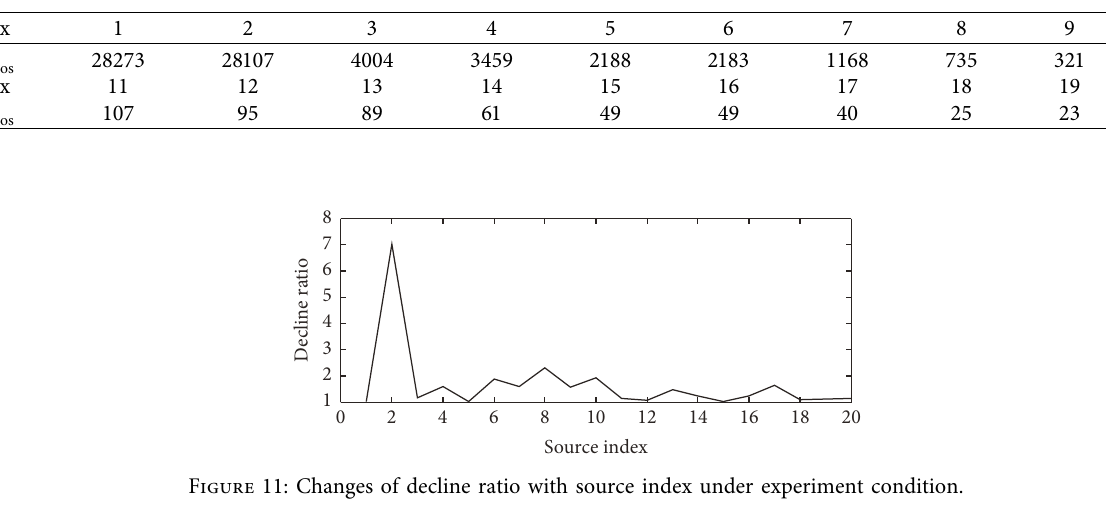
Table 8: Nonzero eigenvalues obtained by SVD.